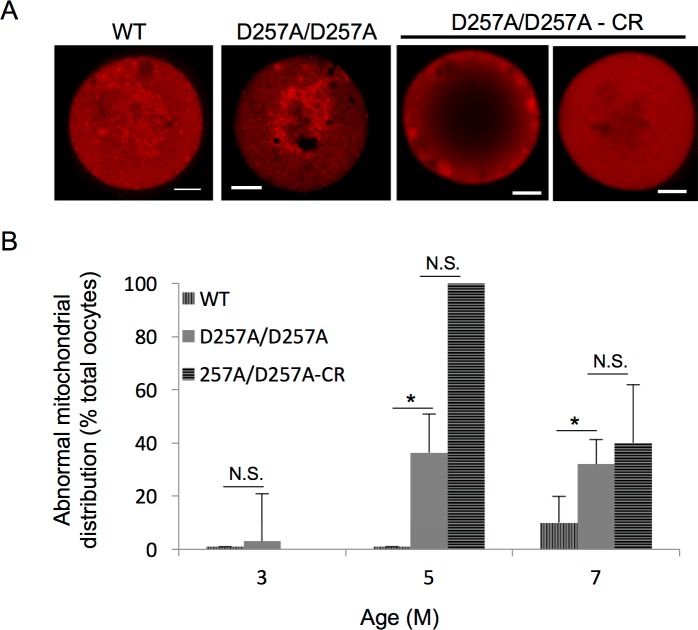
CR does not improve mitochondrial distribution in oocytes from POLGD257A/257A.A. Representative images of MII eggs labeled with MitoTracker (shown in red) from 7-month-old WT, POLGD257A/257A, and POLGD257A/257A-CR mice. Abnormal mitochondrial clustering was prevalent in POLGD257A/257A, whereas oocytes collected from POLGD257A/257A-CR mice demonstrated diffuse mitochondrial labeling. B. Percentage of abnormal mitochondrial distribution in MII oocytes collected from WT, POLGD257A/257A, and POLGD257A/257A-CR mice (mean shown, error calculated as SD of a binomial distribution; only MII analyzed, oocytes were from 3–6 mice per group; N.S., not significant; P > 0.05).